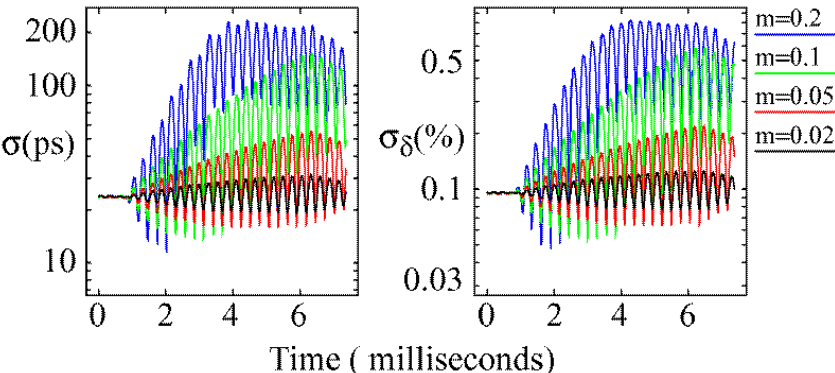
FIG. 5. (Color) Phase-modulation bunch compression technique simulation results.